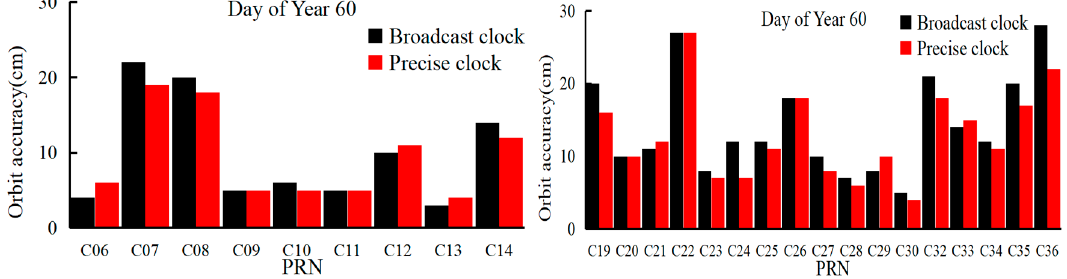
Figure 10. Daily orbit accuracy of each satellite (BDS-2: left , BDS-3: right ) resulting from Scenario 1 (black) and Scenario 2 (red) on DOY 60. Table 4. The average daily accuracy of the BDS rapid orbit resulting from two types of clocks and the corresponding improvements.